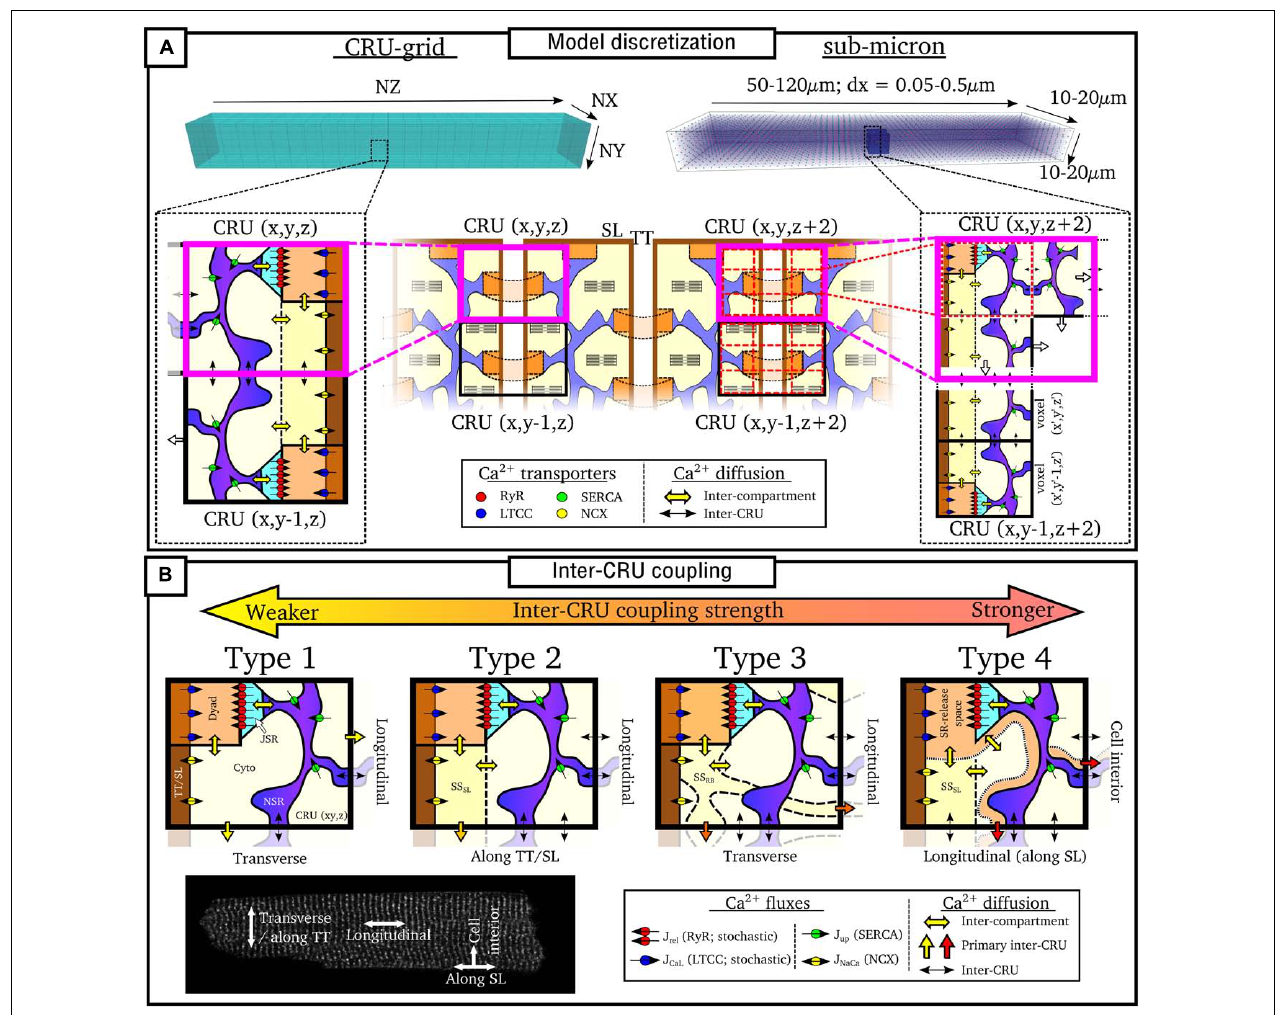
FIGURE 5 | Discretization and CRU coupling of whole-cell models of spatial Ca 2 + handling. (A) Illustration of the CRU-grid and sub-micron approaches to model discretisation. Top panels illustrate the whole-cell whereas bottom panels demonstrate the discretisation of the cell into either CRUs or sub-CRU voxels. (B) Illustration of different model structures for inter-CRU coupling. The primary pathway of CRU coupling in the intracellular space is shown by the colored-block arrows. Note that within the cell, coupling is symmetric in the ± -axes directions; a single direction only is shown for the purpose of clarity. Cell image for illustration provided by Dr. Izzy Jayasinghe, The University of